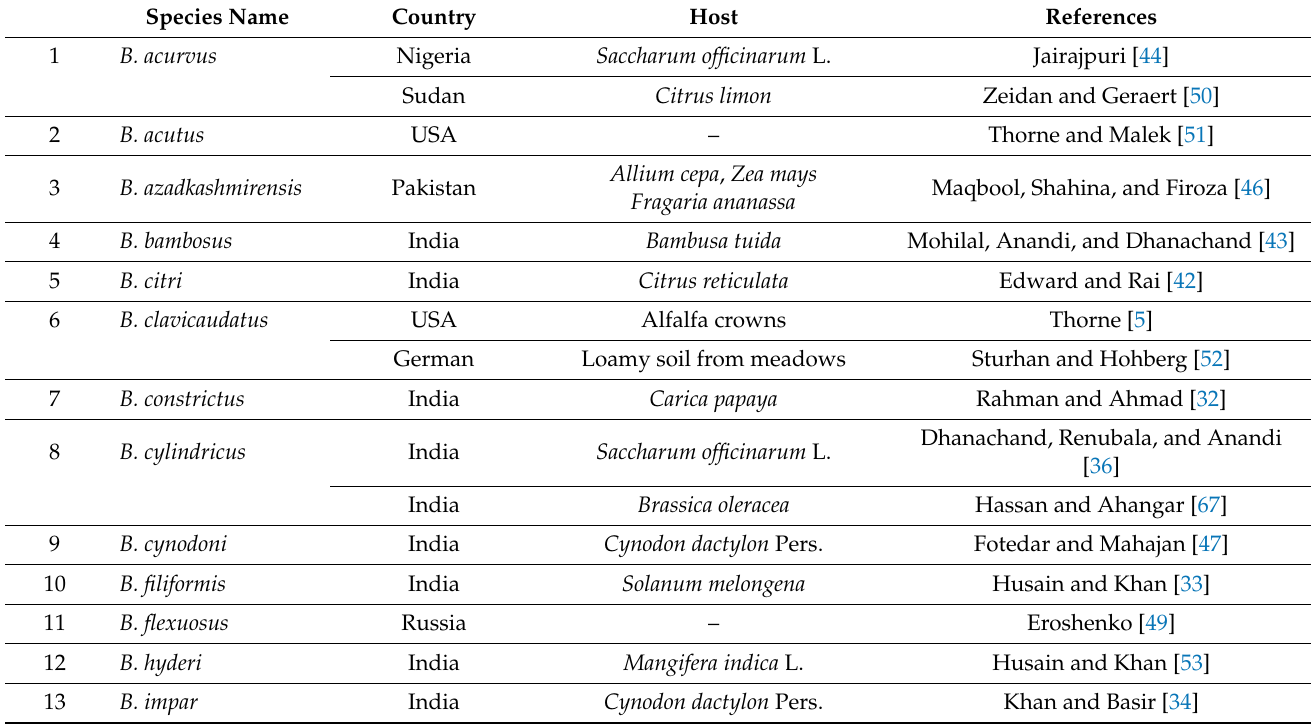
Table 5. Distribution and associated hosts of Boleodorus